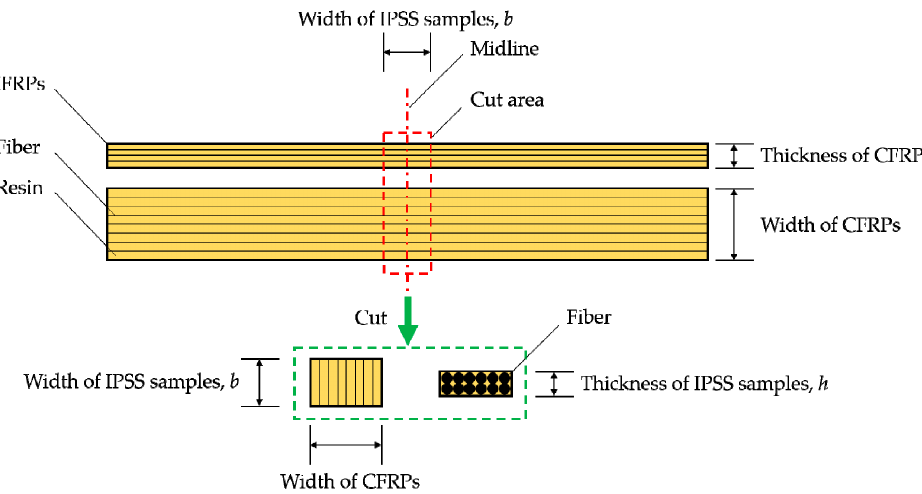
Figure 4. Position of the IPSS testing sample on CFRPs.